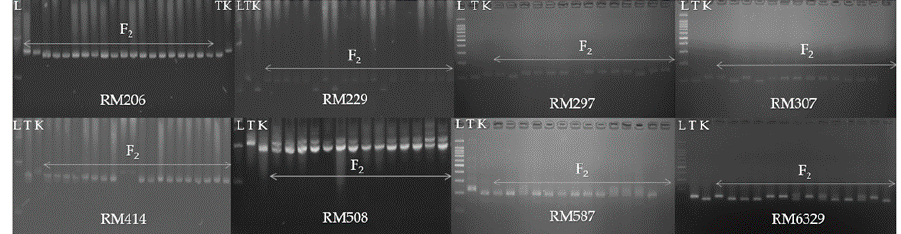
Figure 2. PCR products of F 2 generation by simple sequence repeat (SSR) markers RM206, RM229, RM297, RM307, RM414, RM508, RM587, and RM6329 (L: DNA ladder, T: TBR1, K: KD18, F 2 : F 2 progenies).